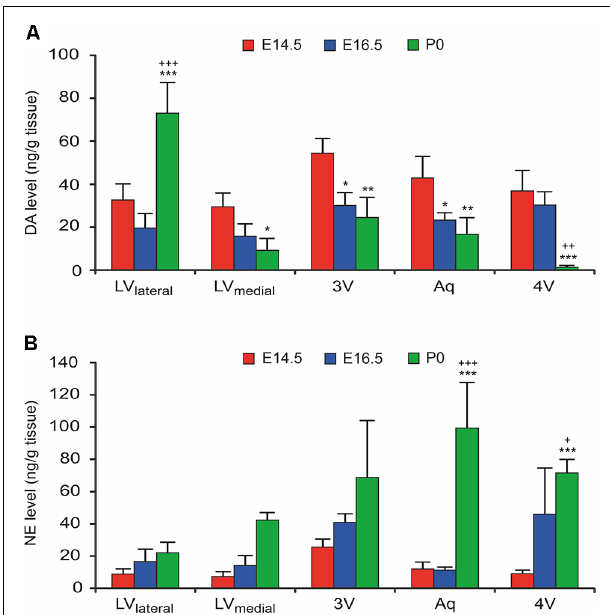
FIGURE 3 | Catecholamine levels in microdissected VZ/SVZ regions of the developing mouse brain (at developmental stages E14.5, E16.5. and P0). Catecholamine levels were measured in microdissected VZ/SVZ regions using an HPLC with electrochemical detection and normalized to tissue weight. (A) Dopamine (DA) levels were increasing in the VZ/SVZ of the LV lateral walls (LV lateral ), while they were continuously declining during development in the caudal VZ/SVZ regions. Two-way ANOVA with brain regions and developmental stages as fixed factors revealed that VZ/SVZ regions and stages had a significant interaction effect on DA levels ( P < 0.001, F -value = 13.3) and significant differences among VZ/SVZ regions ( P < 0.001, F -value = 10.3) and stages ( P < 0.001, F -value = 14.1). (B) In contrast to DA, norepinephrine (NE) showed continuously increasing levels in the caudal (hindbrain) VZ/SVZ regions during development. Two-way ANOVA revealed that VZ/SVZ regions and stages had a significant interaction effect on NE levels ( P = 0.001, F -value = 4.3) and significant differences among VZ/SVZ regions ( P = 0.003, F -value = 5.3) and stages ( P < 0.001, F -value = 32.4). P -values from post hoc tests with Bonferroni adjustment are * P < 0.05, ** P < 0.01 and *** P < 0.001 when compared to E14.5 and + P < 0.05, ++ P < 0.01 and +++ P < 0.001 when compared to E16.5 (only P -values among developmental stages are displayed for clarity; complete statistics in Supplementary Tables S2 , S3 ). 3V, third ventricle; 4V,